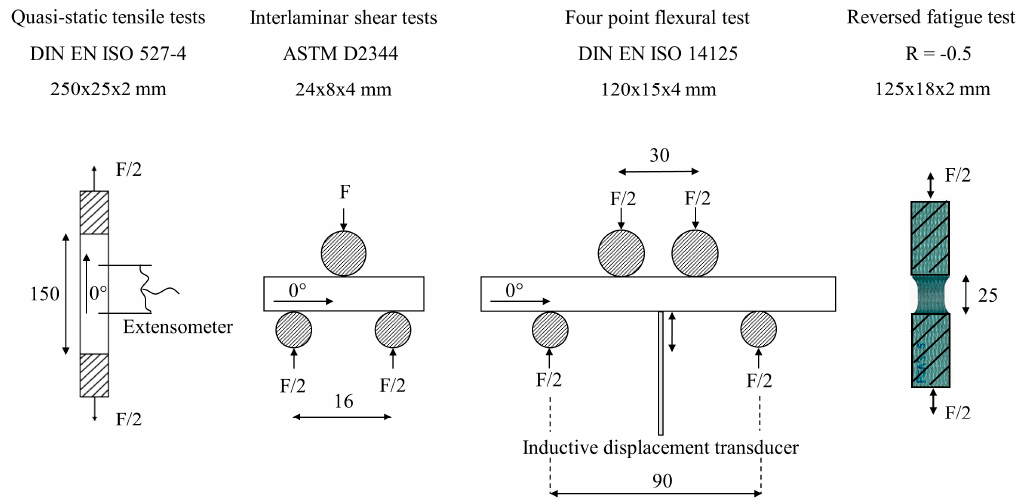
Figure A1. Schematic test configurations of the static and fatigue tests performed. Numbers are given in mm. Further details can be found within the Section 2.